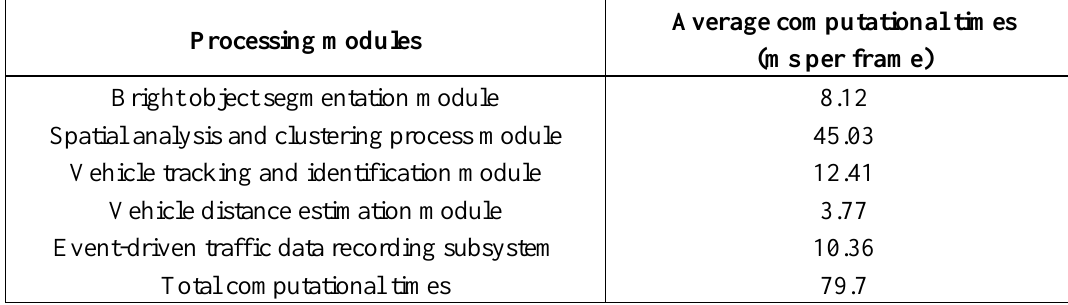
Table 3. The computational timing data of the vision processing modules of the proposed VIDASS